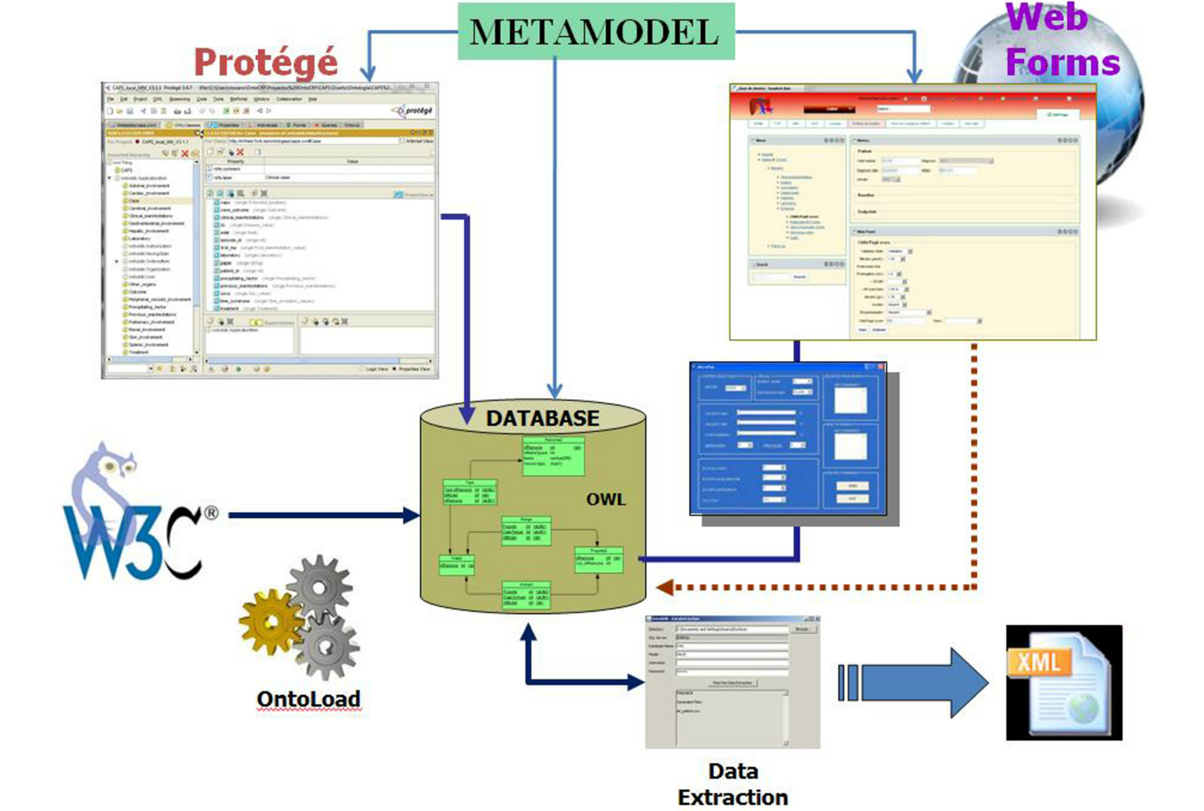
Figure 3. General architecture of